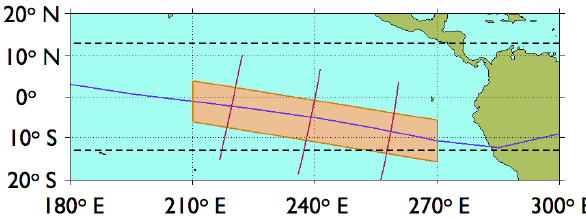
Fig. 3. The test region over the Pacific Sector. The red lines rep- resent the three discrete SAMI2 runs. CINDI data throughout the orange box is averaged together to provide the average densities for the SAMI2